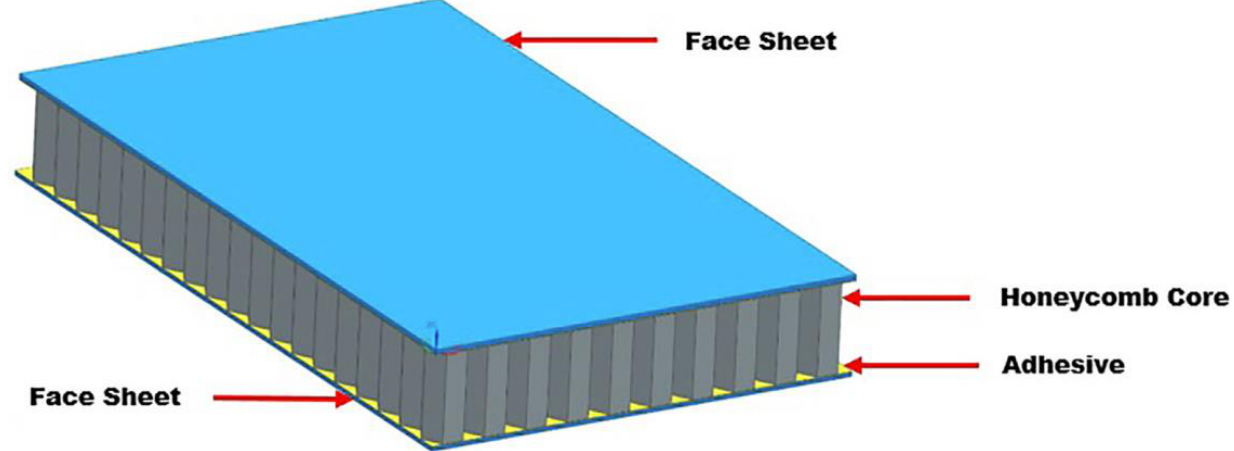
Figure 1. 3D model of honeycomb sandwich structure.